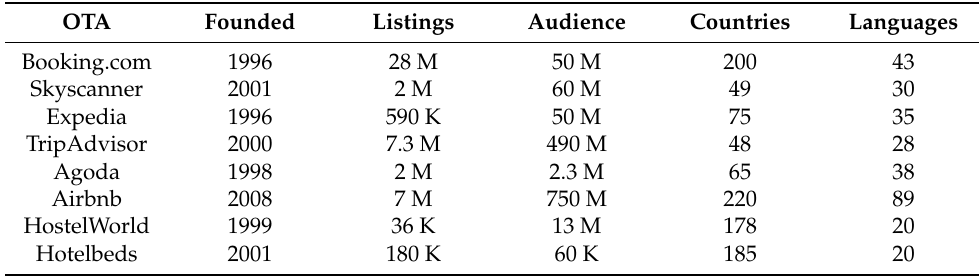
Table 5. OTAs (source: Cloudbeds,